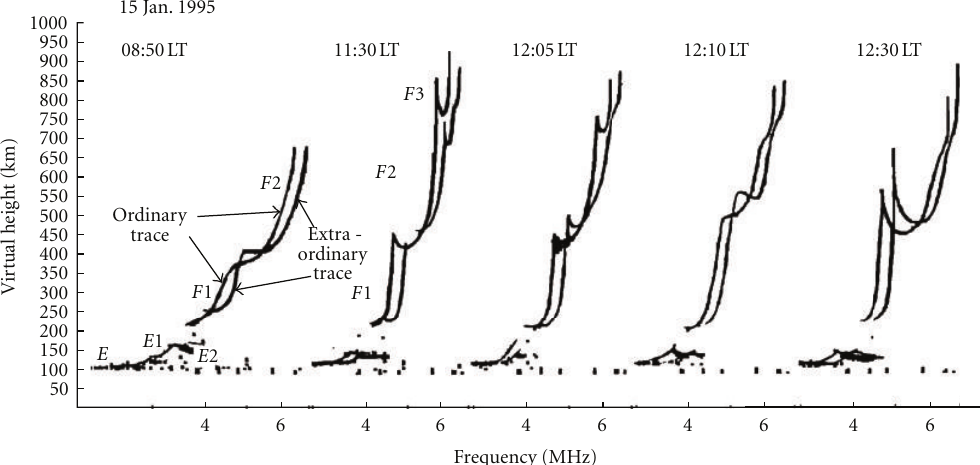
Figure 10: Sample ionograms recorded at Fortaleza on January 15, 1995. Note the development and decay of the F3 layer as an additional trace at the high-frequency end at the virtual altitude of about 750 km, which is most distinct at 11:30 LT (from Balan et al.